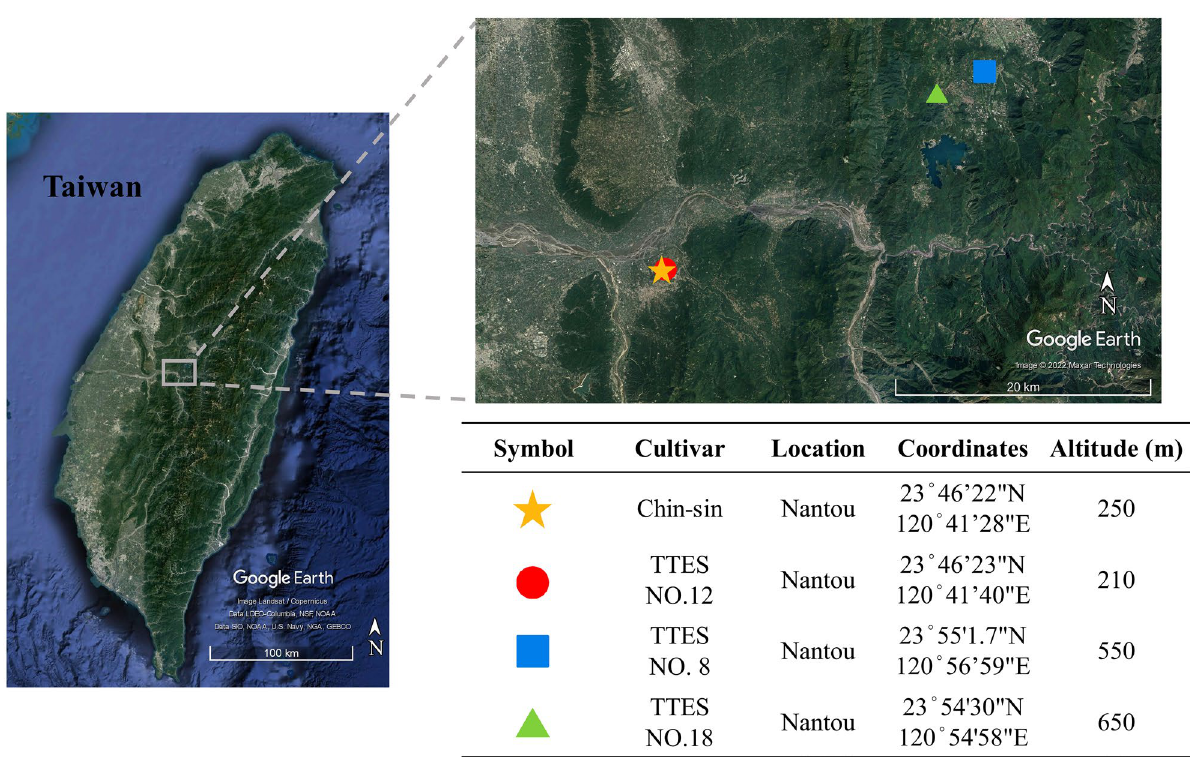
Figure 6. Geographic location and information of tea gardens of different cultivars. Tea samples were collected from these locations in Nantou, Taiwan. Different symbols represent the tea gardens of different cultivars. Base imagery was captured from Google Earth. Map data source: Google, LDEO-Columbia, NSF, NOAA, SIO, U.S. NAVY, NGA, GEBCO, Maxar